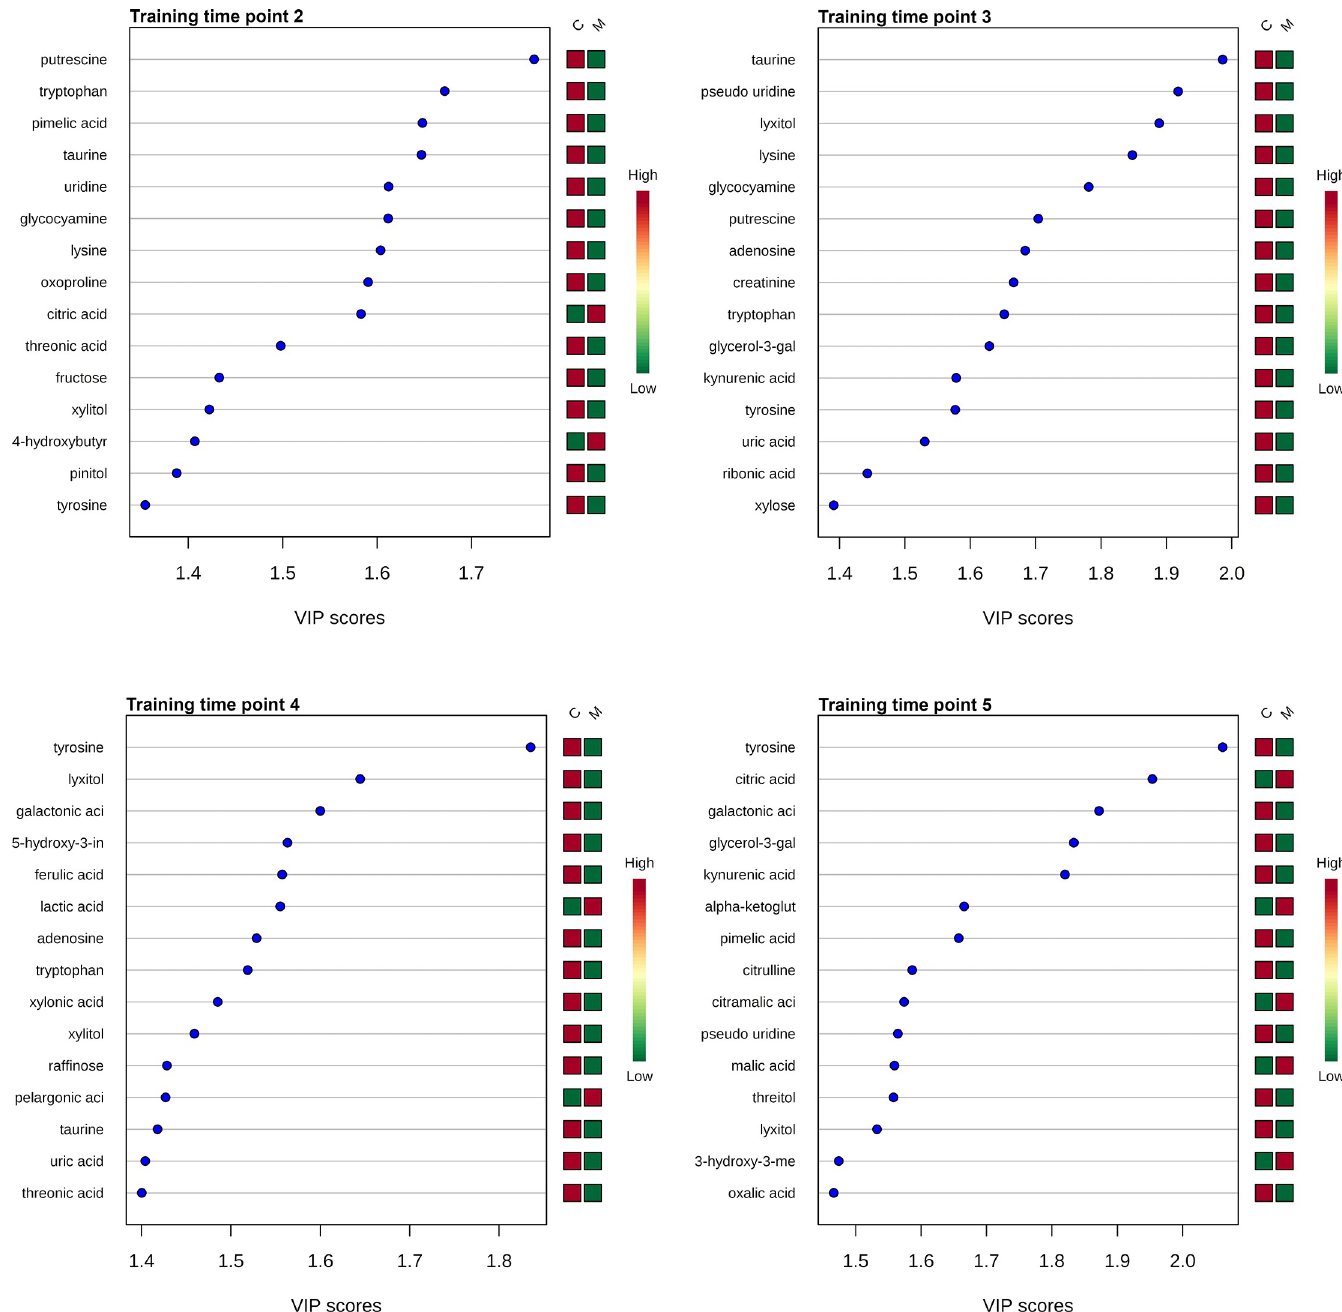
Fig 2. Variable importance in projection (VIP) scores for the top 15 metabolites. VIP scores of top 15 urine metabolites used to differentiate meloxicam-treated (n = 5) and saline-treated cats (n = 6). VIP scores are derived from PLS-DA analysis performed at each time point, 1–5. VIP scores � 1.0 were considered significant when selecting metabolites for the final model. The column to the right of each figure display variations in metabolite peak